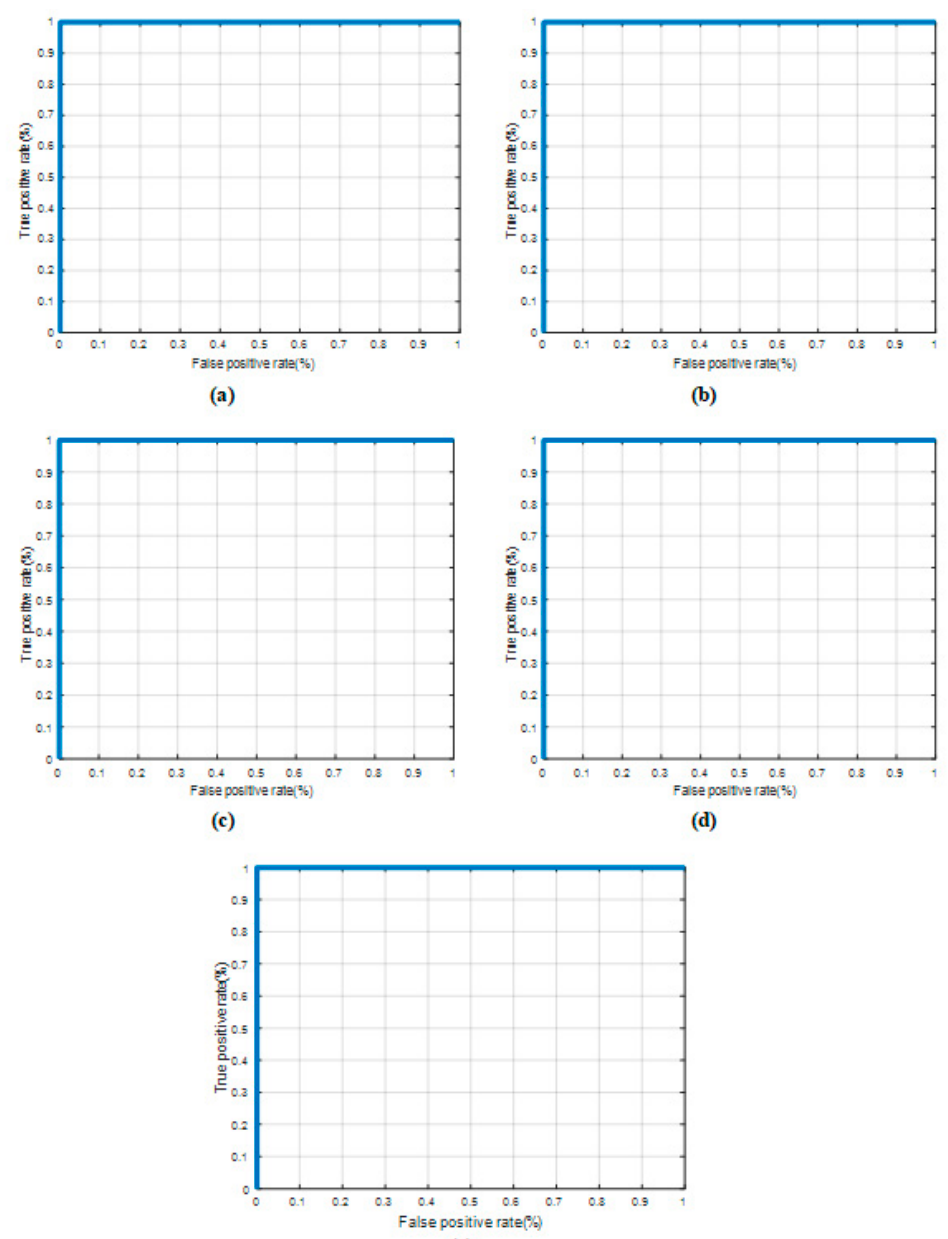
Figure 16. ROC curve for the system using a modified logistic map and an encrypted kernel with ( a ) circular encryption, ( b ) IWT encryption with similar keys for all sub-bands, ( c ) IWT encryption with different keys for all sub-bands, ( d ) DWT encryption with similar keys for all sub-bands, ( e ) DWT encryption with different keys for all sub-bands. Table 4. The encryption domain effect using a modified logistic map.